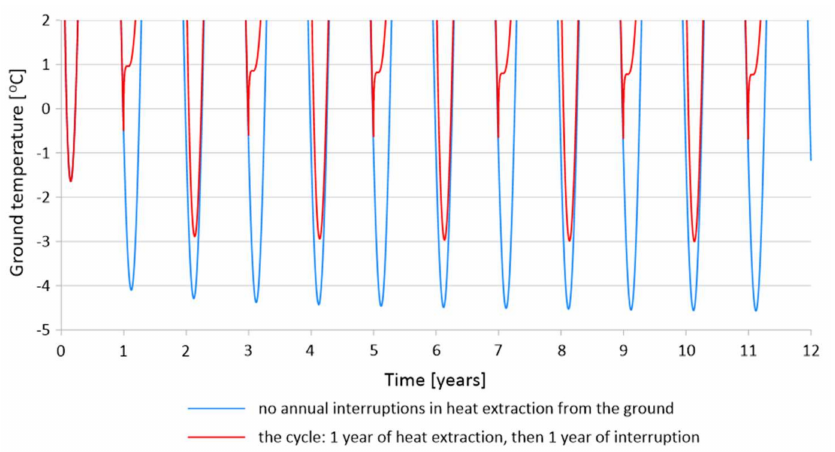
Figure 10. Time series of ground temperature at the depth of heat exchanger’s installation at different operation modes: k = 1.4 W/ ( mK ) ; q max = 10 W/m 2 ; κ = − 1, RH = 0.79, f = 0.3, (cid:0) (cid:1) h = 15 W/ m 2 ,K